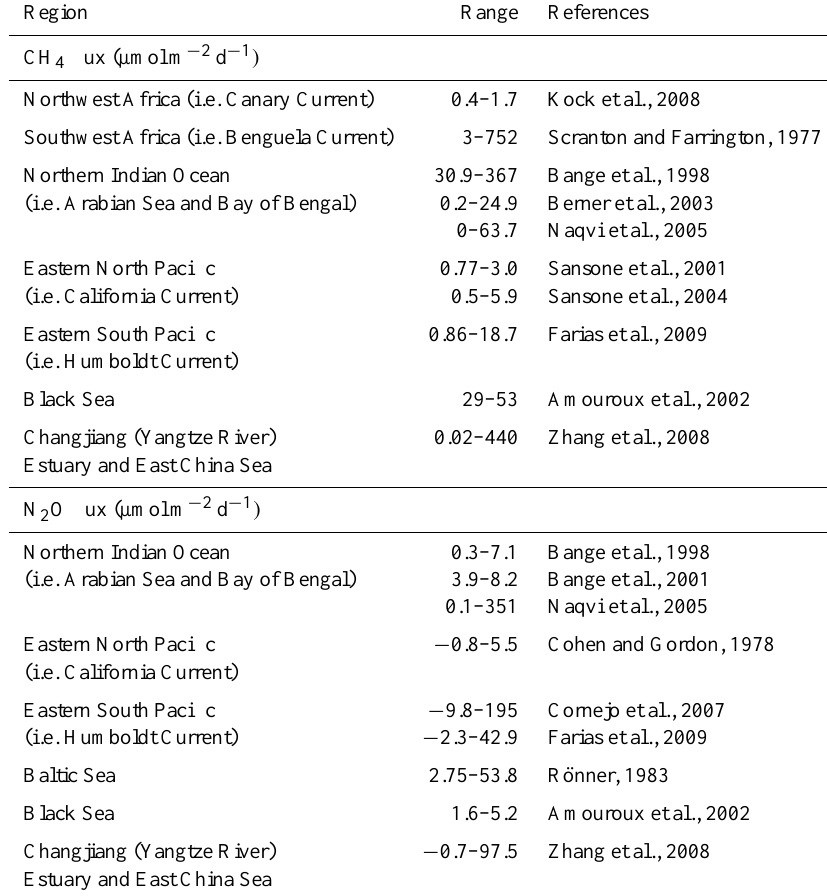
Table 2. Emission fluxes of CH 4 and N 2 O from major coastal hypoxic